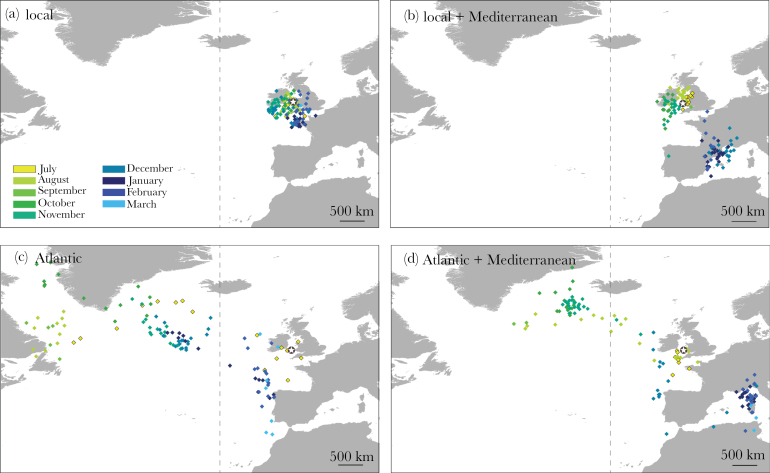
Example of each type of migration routes. Each point is a daily position. Each color represents a different month. The colony is represented with a star, the −20° meridian that was used as a threshold between “local” and “Atlantic” routes is represented with a dashed line. The breeding season (April to mid-July) is not represented. The points on land are due to low resolution of the data (~185 km) rather than actual positions on land. (a) Local (n = 47), (b) local + Mediterranean (n = 3), (c) Atlantic (n = 45), and (d) Atlantic + Mediterranean (n = 16).